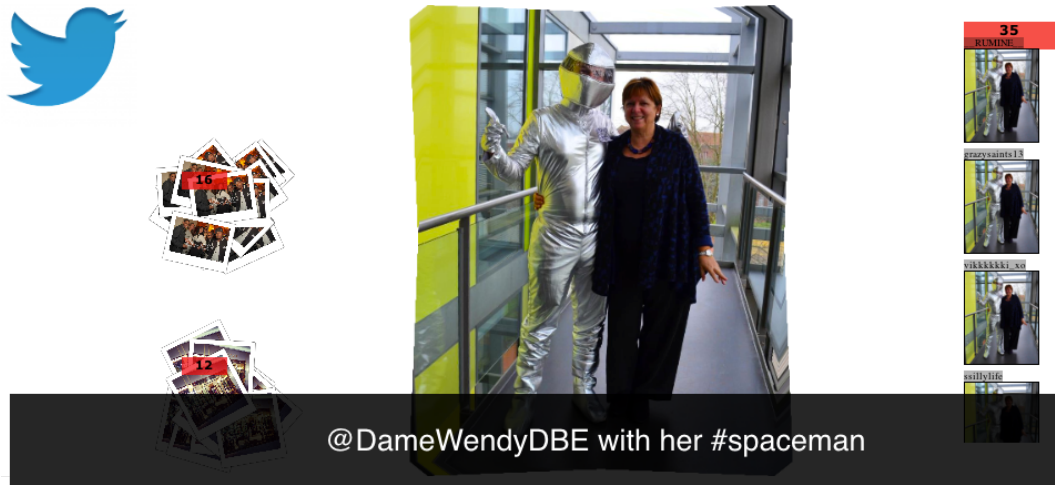
Figure 4. Visualising trending images on Twitter. The image in the centre was the most popular image at the time of capture; on the right-hand side are some of the instances of this image. The small piles of images on the left correspond to other images that are currently trending ( i.e. , they appear multiple times in the time-window); these can be clicked on to expand them. The text of Tweets related to the currently selected trend are shown at the